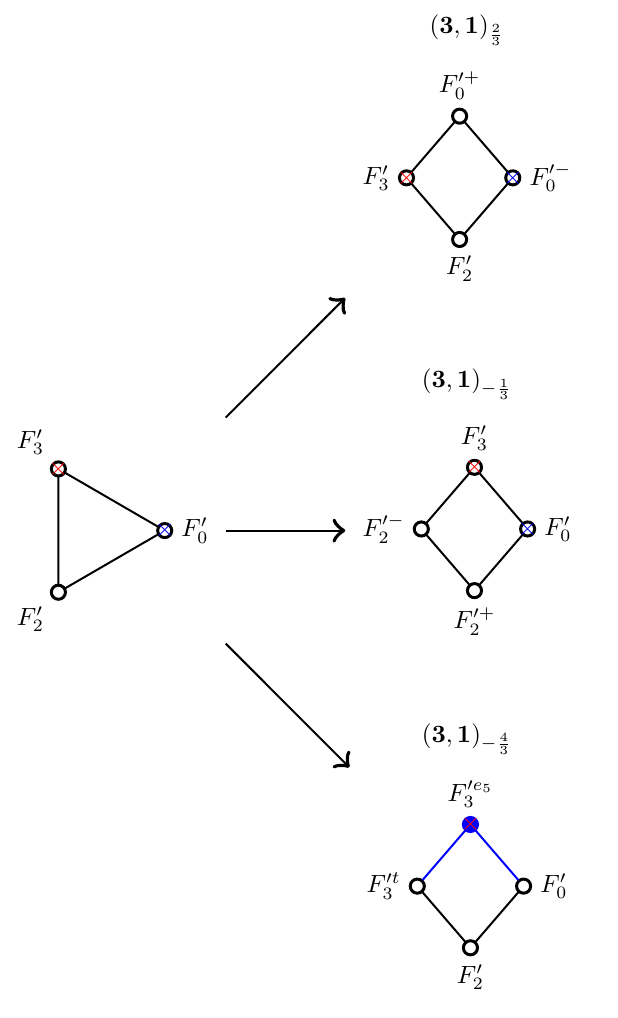
Kodaira fibers over the 3